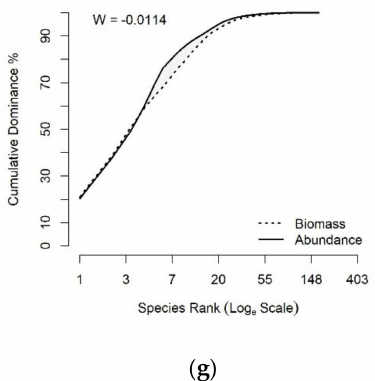
Figure 4. Comparison of abundance and biomass curves by group: ( a ) group 1a, ( b ) group 1b, ( c ) group 2a, ( d ) group 2b, ( e ) group 3a, ( f ) group 3b, and ( g ) group